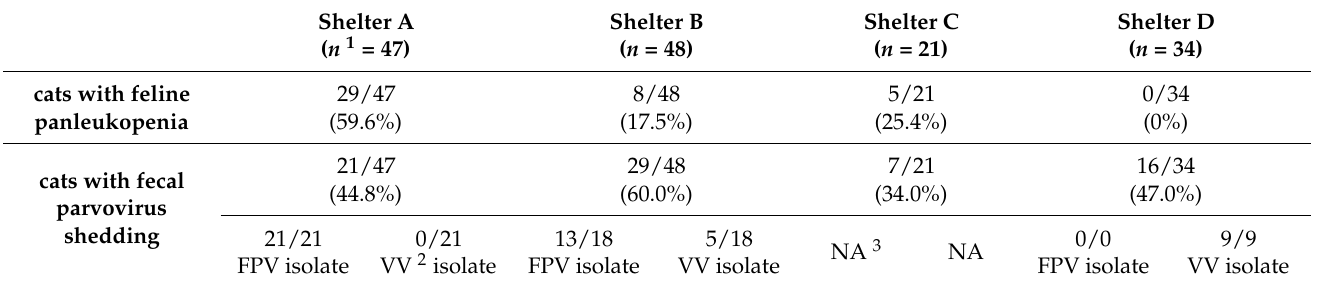
Table 1. Percentage of cats with feline panleukopenia and fecal parvovirus shedding (including sequencing results to differentiate between FPV isolates and vaccine virus isolate) in all 4 shelters. Shelter A